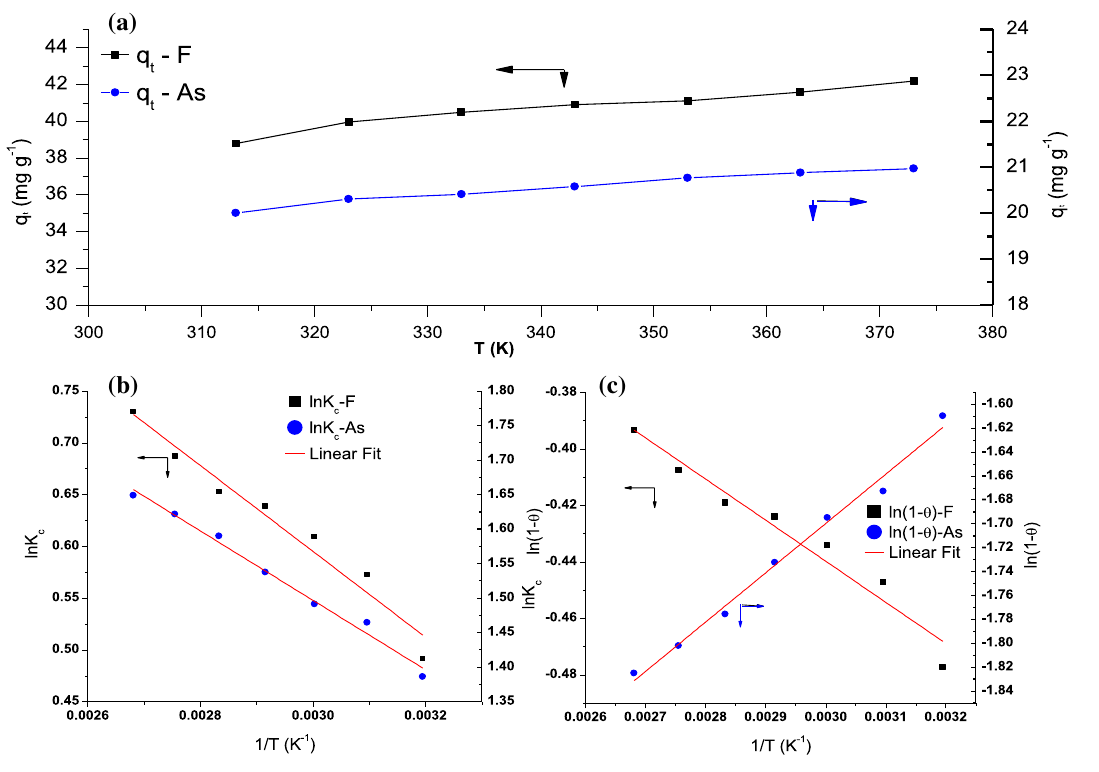
−1 and c plot of ln(1− θ )versus T −1 for Fluoride C vs T